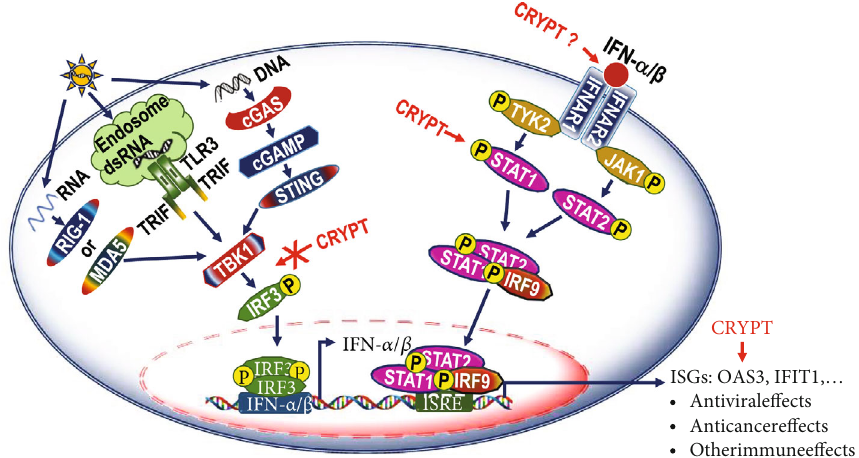
Figure 8: Proposed upregulation of the IFN-1 response pathway by cryptolepine. Cytosolic RNA is detected by the MDA5 or RIG-1 which leads to the activation of IRF3 via the TBK1. However, cytosolic DNA is recognised by cGAS which then stimulates the STING-dependent signalling, leading to the phosphorylation of IRF3. The phosphorylated IRF3 homodimerises and moves into the nucleus causing the release of the IFN-1 (mainly IFN- α / β ). The secreted IFNs simulate the later phase of the IFN-1 pathway (JAK-STAT axis) through the IFNARs, which transmit a cascade of signalling events to activate the promoters of ISGF3 and induce the production of numerous IFN-responsive proteins which facilitate anticancer and antiviral responses. This study has demonstrated that cryptolepine activates the IFN-1 response pathway via the JAK-STAT axis (as indicated by arrows) but is independent of the fi rst phase of the pathway (as indicated by a crossed arrow). CRYPT: